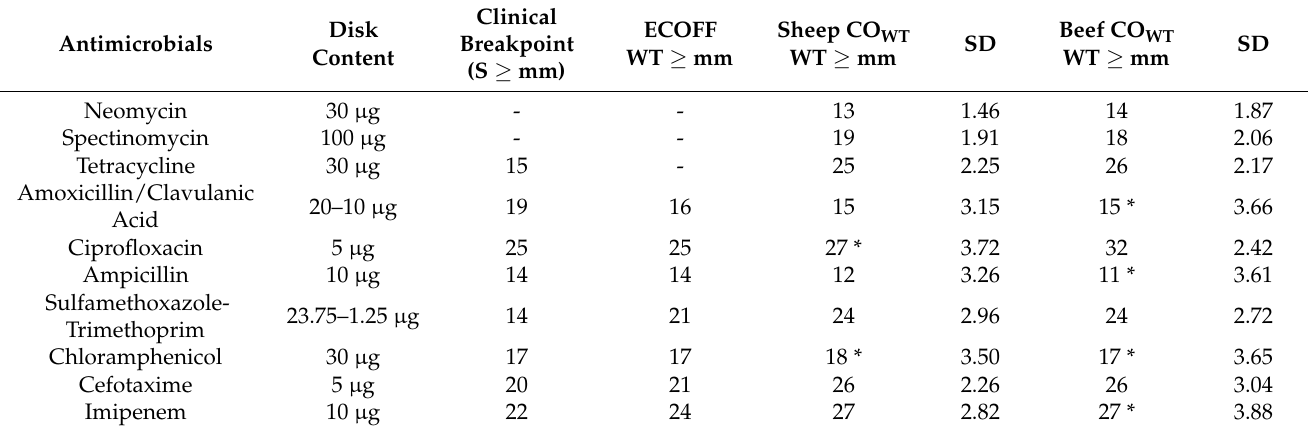
Table 2. Epidemiological cut-off values calculated using the NRI method compared with clinical breakpoints and ECOFF val- ues. Disk Antimicrobials Content